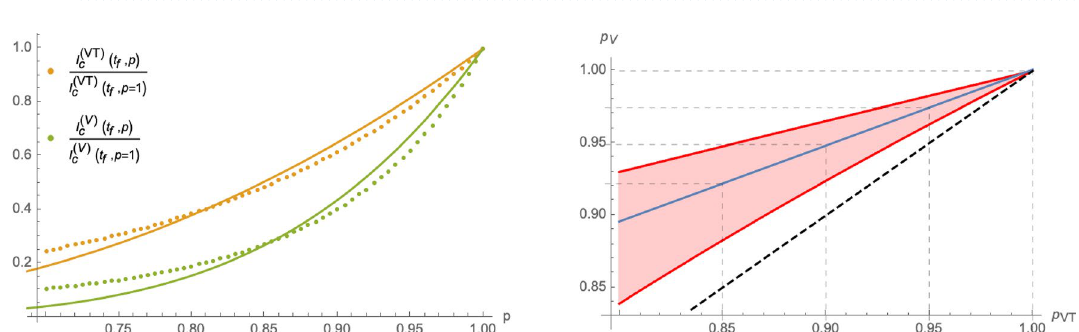
Figure 9. Comparison of the V-HP model (6) and the VT-HP model (4): the left panel shows the cumulative number of infected individuals at t f = 15 / 09 / 2021 as a function of p (normalised to the value of p = 1 ). The orange curve corresponds to the model (6) and the green curve to the one in (4). The right panel shows the equivalence for the parameters p VT and p V of these two models, taking into account the incertitude inherent in the approximations: the red band indicates equivalent values of these parameters that lead to the same value of I c ( t f ) with the blue line corresponding to equivalence obtained comparing equivalent extrapolations of the data in each